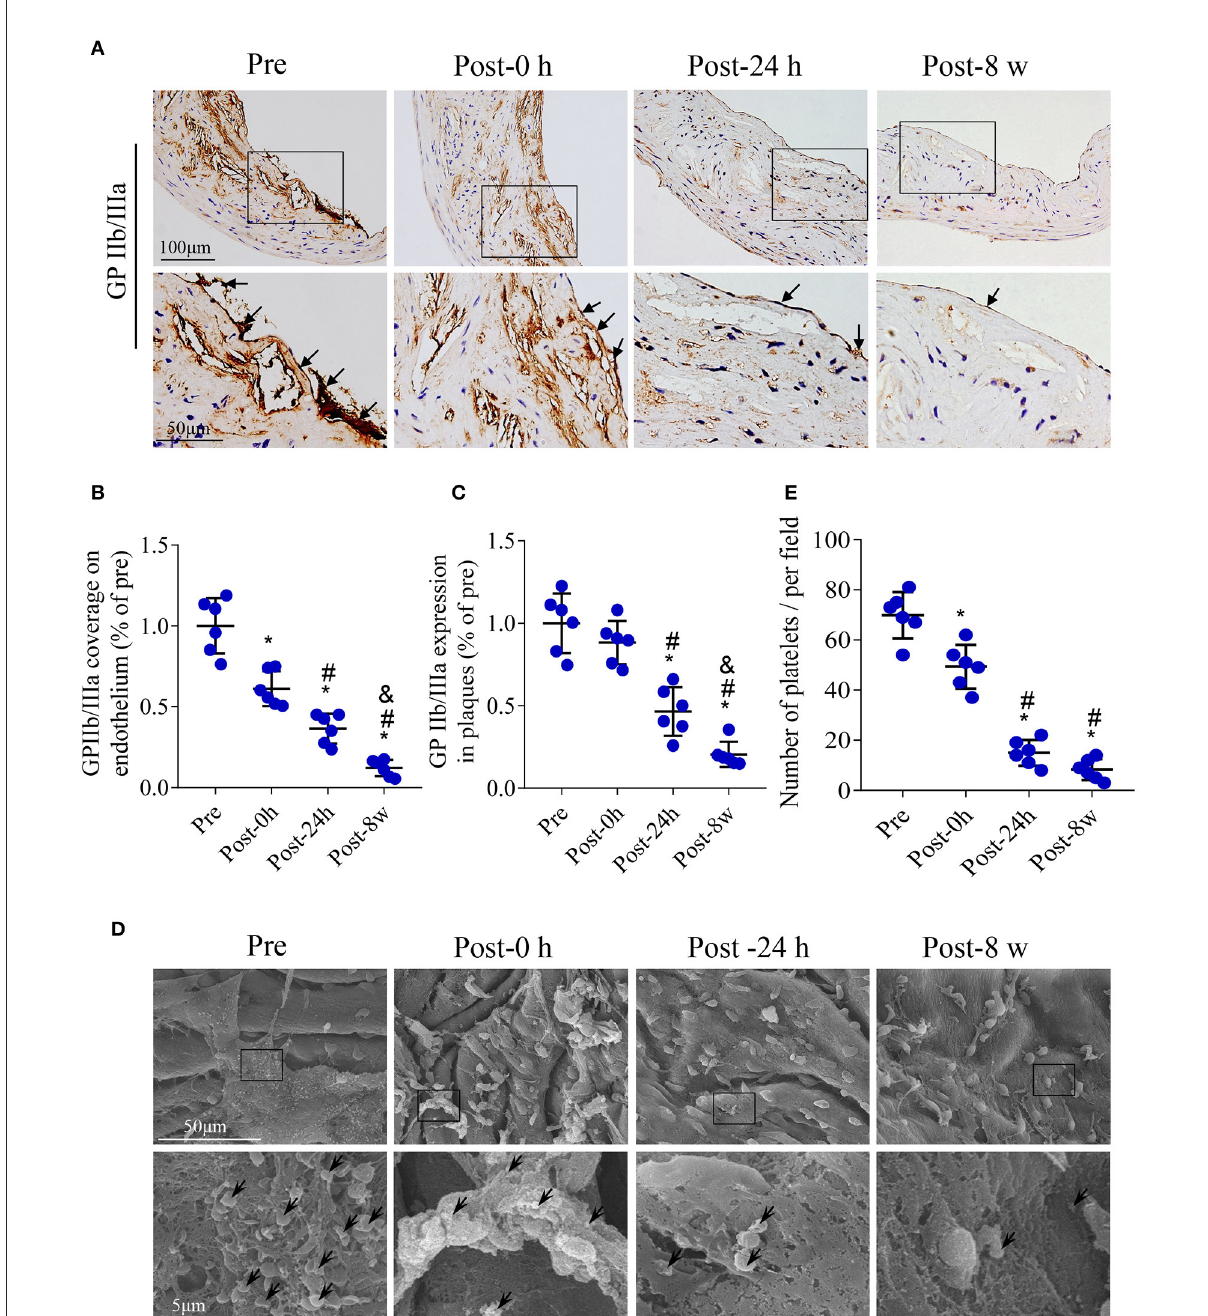
FIGURE5 Effects of DUMB R treatment at an MI of 1.5 on activated platelets in plaques. (A) Representative images of GP IIb/IIIa labeling in plaques and the endothelium (arrows) of the aorta are shown. Quantifications of (B) GP IIb/IIIa coverage of the endothelium and (C) total plaque GP IIb/IIIa content are shown. (D) Platelets (black arrowheads) adhering to the endothelium of atherosclerotic lesions were observed by scanning electron microscopy. (E) Quantitative analysis of the average number of activated platelets. n = 6 per group. * P < 0.05 vs. pretreatment, # P < 0.05 vs. Post-0h, & P < 0.05 vs.